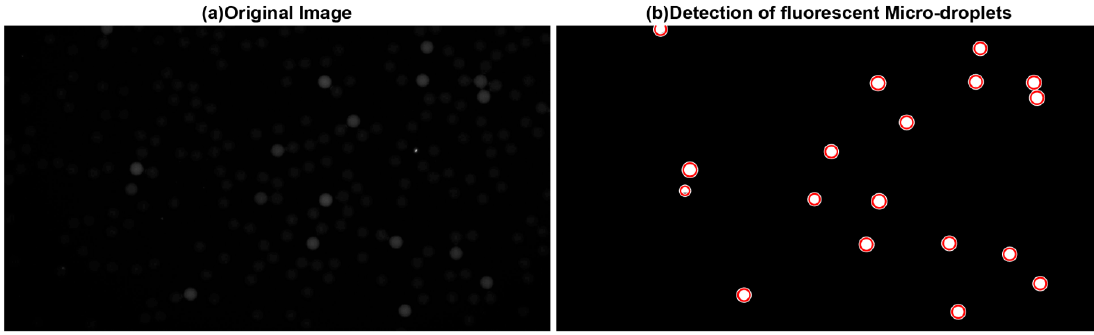
Figure 4. Detection of fluorescent micro-droplets. ( a ) Original image. ( b ) Detection of fluorescent